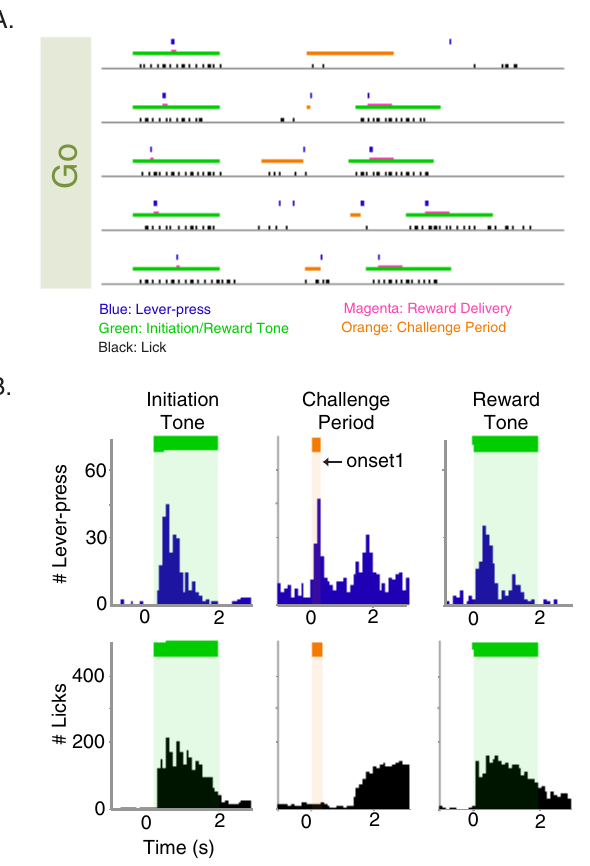
Figure 4. Raster plot of five consecutive Go trials ( A ) and histograms of lever pressing and licking during the initiation tone, challenge period, and reward tone ( B ). Green bar: initiation tone and reward tone, orange bar: challenge period, magenta bar: reward delivery, black: lick, blue: lever press. (Histogram bin size=100 ms). The second peak on the histogram of lever pressing during the challenge period represents lever presses during the final reward tone. Note the emergence of non cued lever presses and licking during the challenge period that represents the idiosyncratic variable initiation during the Go challenge tone and subsequent reward tone delivery under the Go condition.